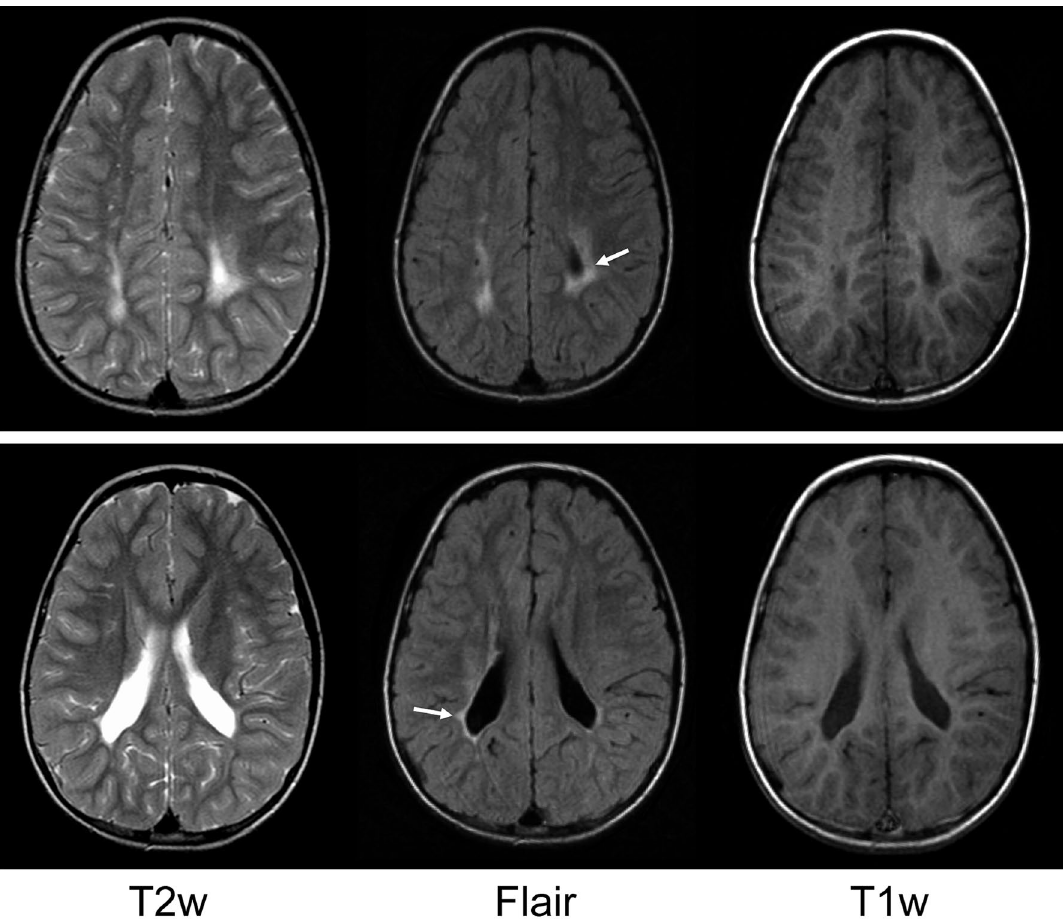
Figure 1. Periventricular leukomalacia (PVL) as depicted by MRI at a later stage after completed myelination in a 6-year-old male born at 32 weeks of gestation. Axial T2-weighted (T2w), FLAIR and T1-weighted (T1w) images at the level of the centrum semiovale cutting the upper part of the ventricles (top row) and at the level of the lateral ventricles (bottom row) show the characteristic gliosis as hyperintense high signal on the T2-weighted image and hypointense low signal on the T1-weighted image. The gliosis is best seen on FLAIR images, where the periventricular hyperintensities contrast with the hypointense CSF signal. The top row illustrates gliosis, and the bottom row additional tissue loss (mild ventricular dilatation with irregularly extended borders). From Ref. 5